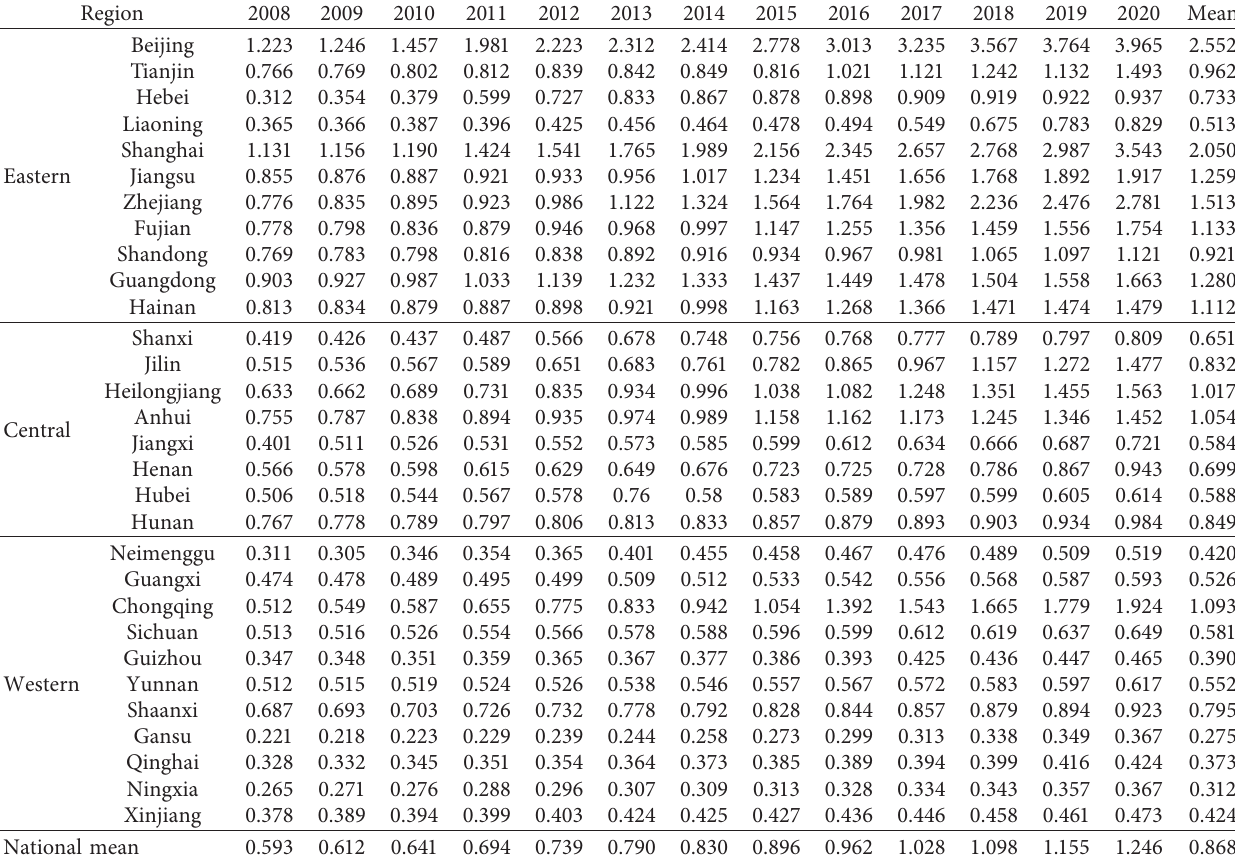
Table 2: Calculation results of regional green economy efficiency.